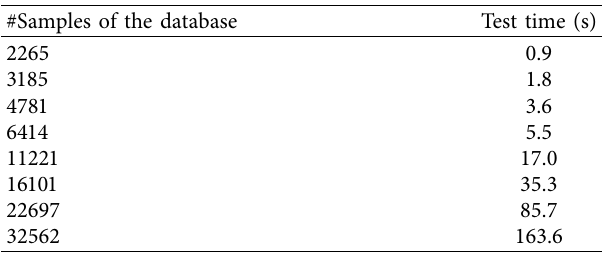
Table 1: Running times of different databases to train an SVM using